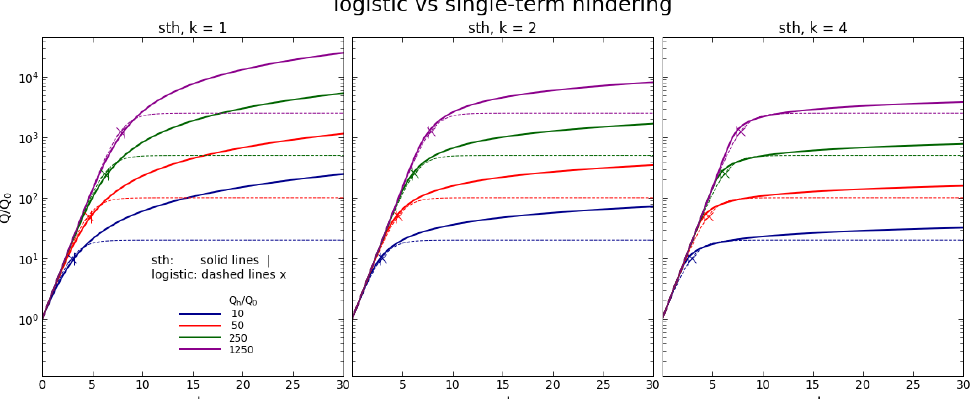
Figure 2. Comparison of growth processes Q (Equation (9)) that follow the sth (Equation (12)) and logistic (Equation (15)) functions with the same g u , Q 0 and Q h for various values of Q h / Q 0 , as marked. Solid lines show sth functions, with short vertical marks ( | ) at Q = Q h ; the logistic is plotted with dashed lines, the hindering marker is × . Each panel shows sth with a different k , as labeled. The logistic curves are the same in all